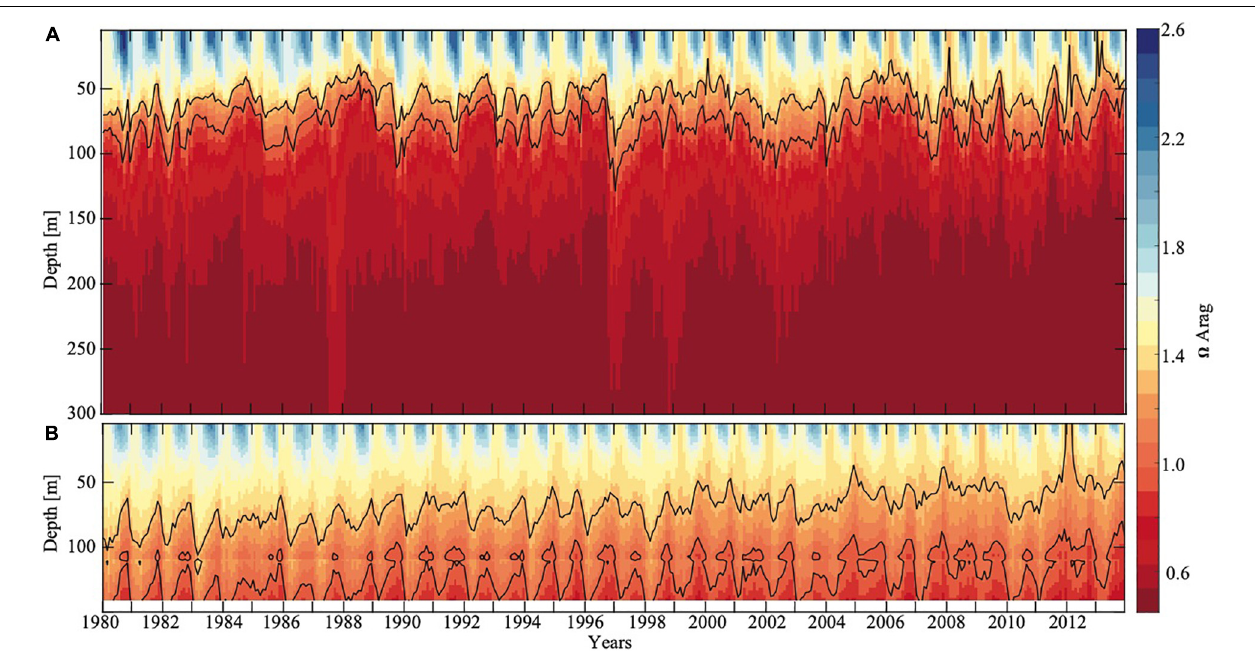
FIGURE 4 | Modeled aragonite saturation state of the Eastern Pacific subpolar gyre and the GoA as a function of depth and time (years) at station 191 ( A , 54 ◦ N and 152 ◦ W) and at a random location on the shelf ( B , 57 ◦ N and 152 ◦ W). Solid black contour lines show (cid:127) ar equal to 1 and 1.3. On the shelf, the seafloor is located at around 140 m depth (white area). Model output is from the GoA -COBALT hindcast simulation described by Hauri et al. (2020).